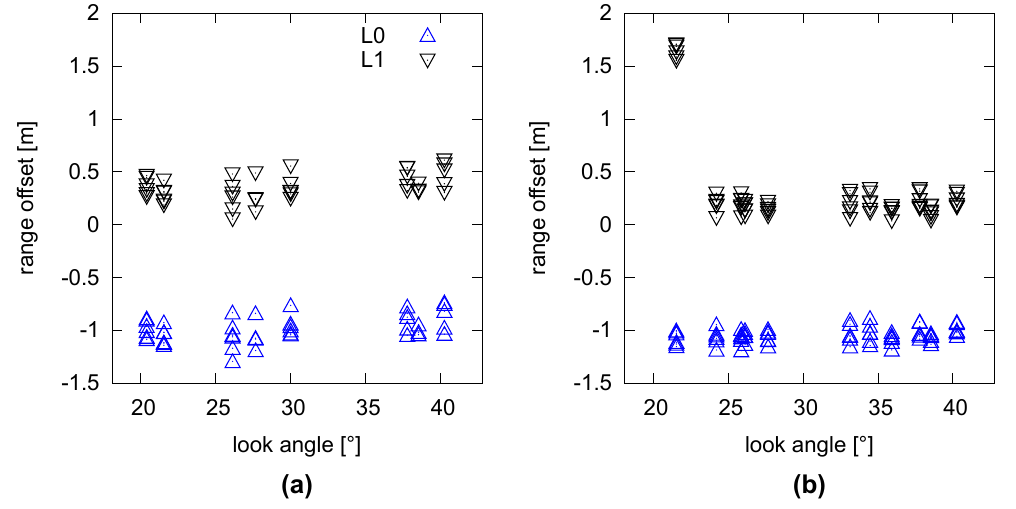
Figure 6. Range offset derived from corner reflector responses for S-1A ( a ) and S-1B ( b ) obtained using both product types: L0 products (blue) and L1 products